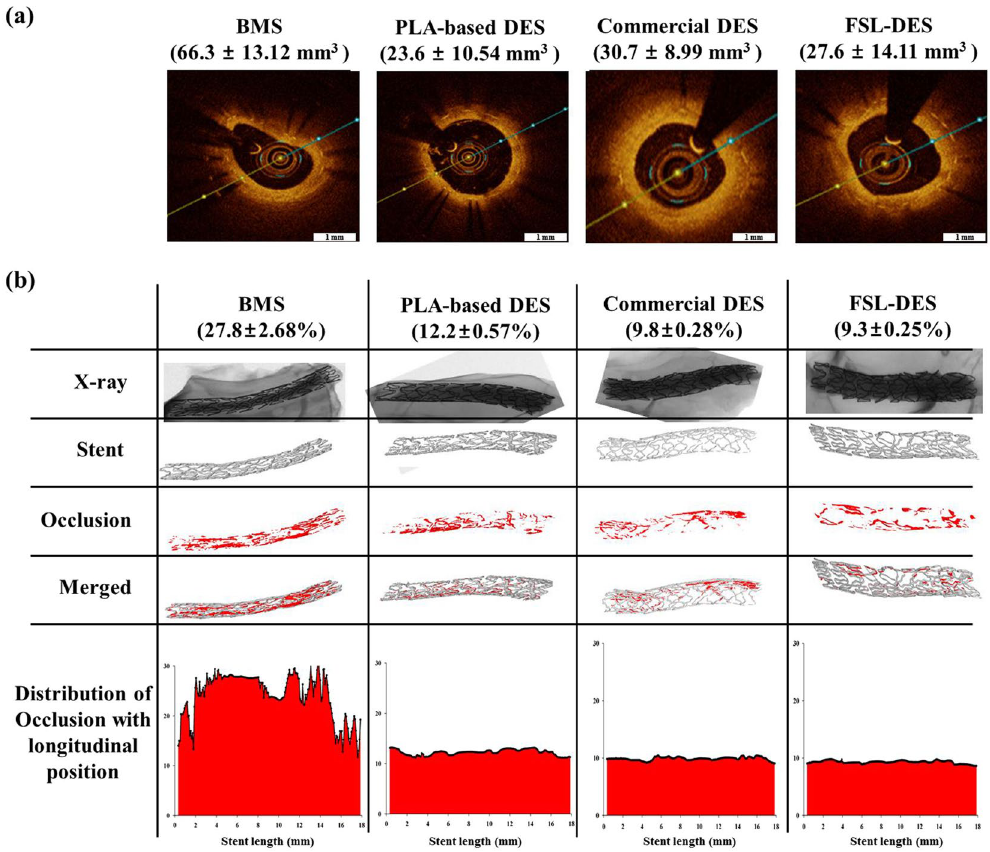
Figure 6. Quantitative analysis of animal study. After 4 weeks of implantation, the vessels surrounding stents were isolated and subjected to OCT ( a ) and microCT ( b ) analysis. Representative images of each was shown (n =